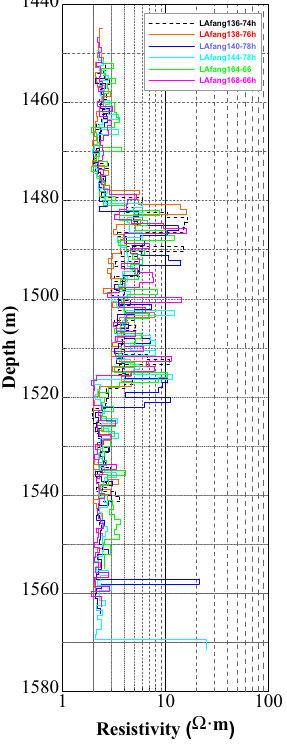
Fig. 2 Logging curve in Daqing Oil Field